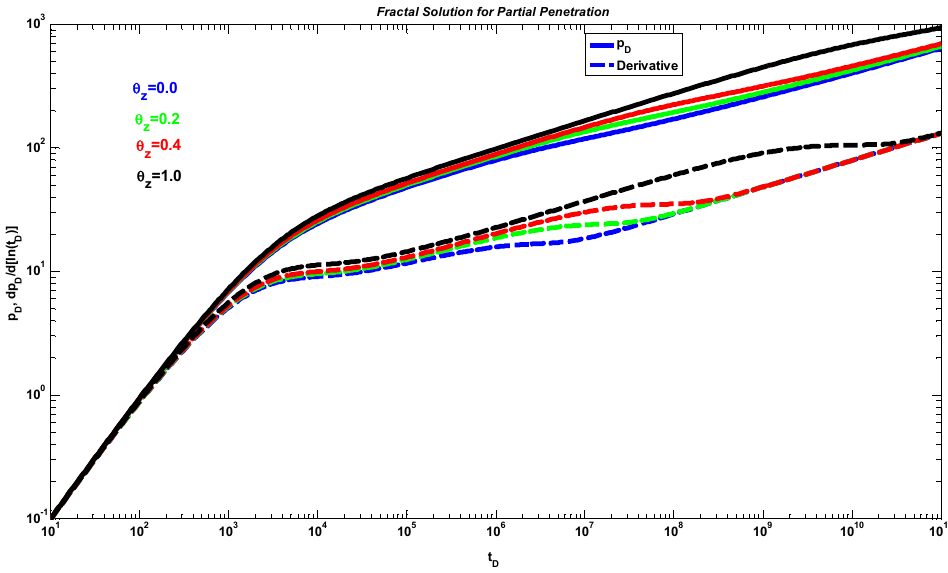
Figure 13. Fractal case: z wD = 0.2, h pD = 0.6, h D = 10,000, S = 0, C D = 100, ε = 1, d fr = 1.8, θ r = 0.3, d fz = 0.8 .